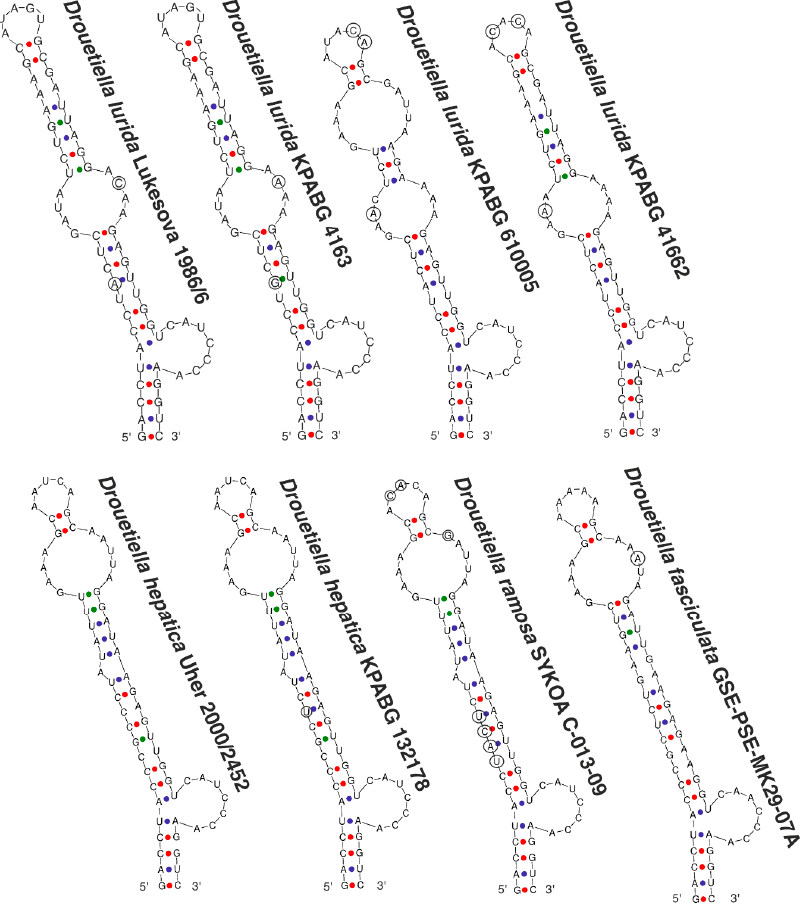
Figure 6. The secondary structure of D1-D1 ′ helices of the 16S-23S ITS rRNA region of Drouetiella strains. Circles indicate differences.